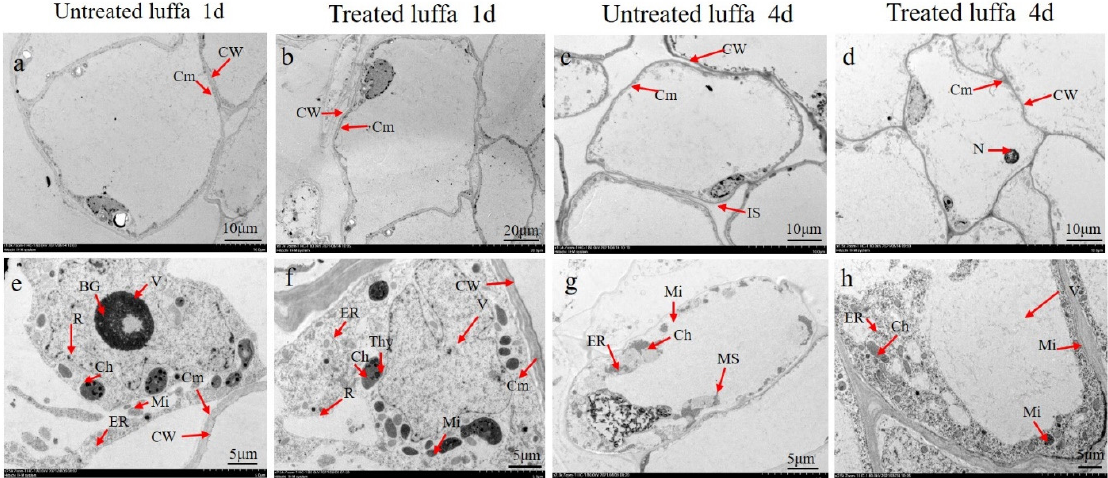
Figure 7. Subcellular structure of fresh-cut luffa. ( a , e ) Ultrastructure of cells in untreated luffa on day 1. ( b , f ) Ultrastructure of cells in treated luffa on day 1. ( c , g ) Ultrastructure of cells in untreated luffa on day 4. ( d , h ) Ultrastructure of cells in treated luffa on day 4. CW, cell wall; Cm, cell membrane; IS, intercellular space; N, nucleus; V, vacuole; BG, high electron-density substances; R, ribosome; Ch, chloroplast; Mi, mitochondrion; ER, endoplasmic reticulum; Thy, thylakoid; MS, myelinic structure.